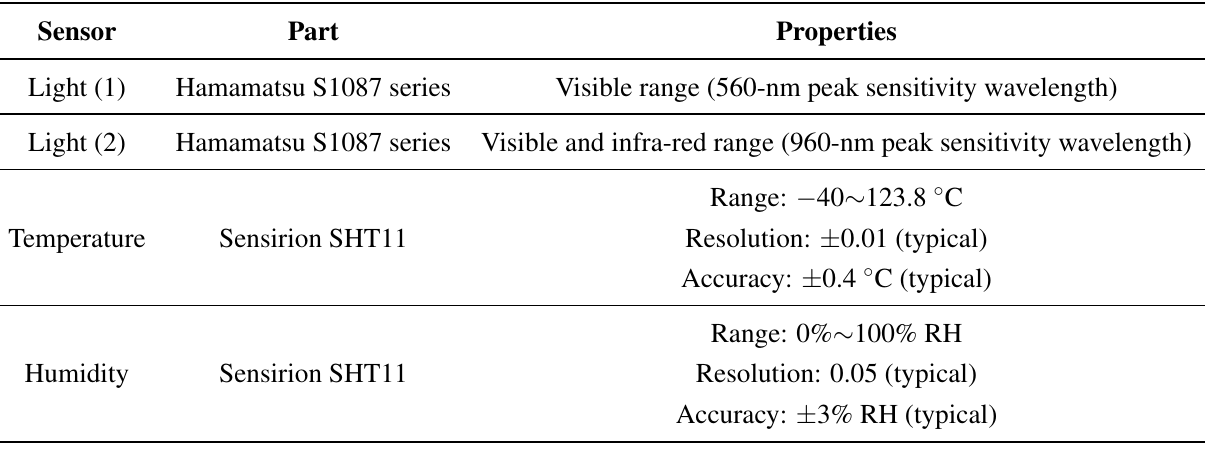
Table 1. Technical specifications of the analyzed on-board